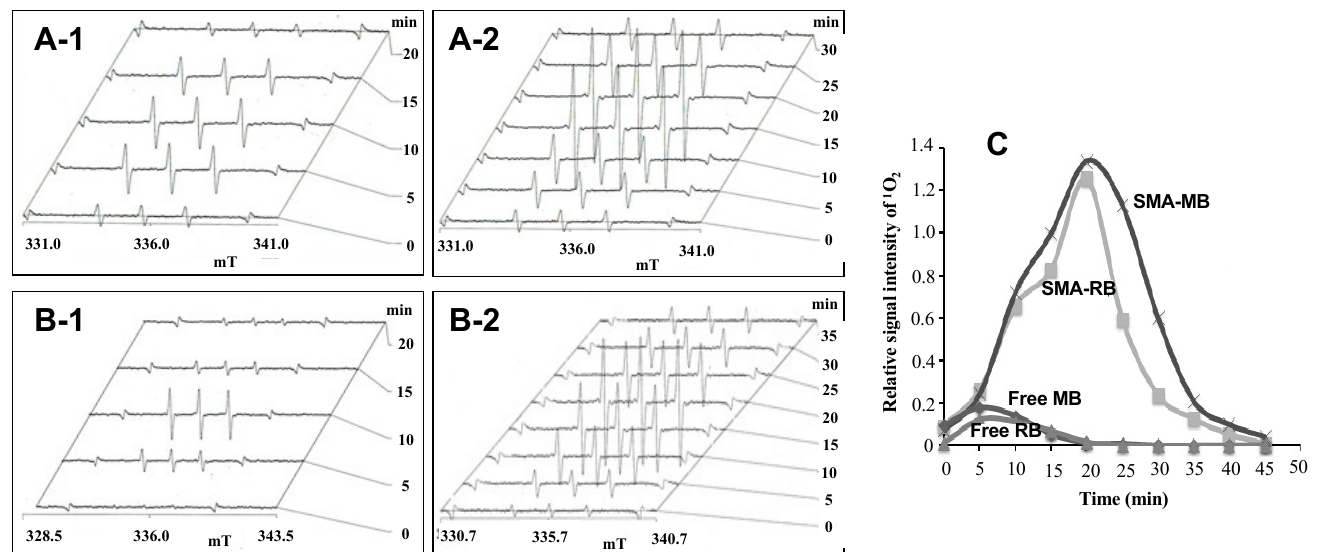
Figure 6. 1 O 2 generation for free RB ( A-1 ), cSMA-RB ( A-2 ), free MB ( B-1 ) and cSMA-MB ( B-2 ) after light irradiation, as measured by electron spin resonance (ESR) spectroscopy. ESR measurement was carried out at the indicated time after the irradiation (see text for details). The relative ESR signal intensities of different PSs and changes over time are shown in ( C ).